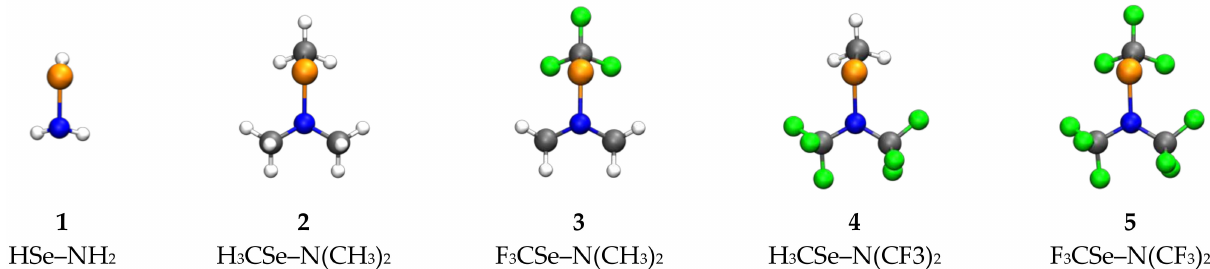
Figure 1. Optimized geometries of selected model molecules of general formula RX–NR’ (X = Se). Level of theory: